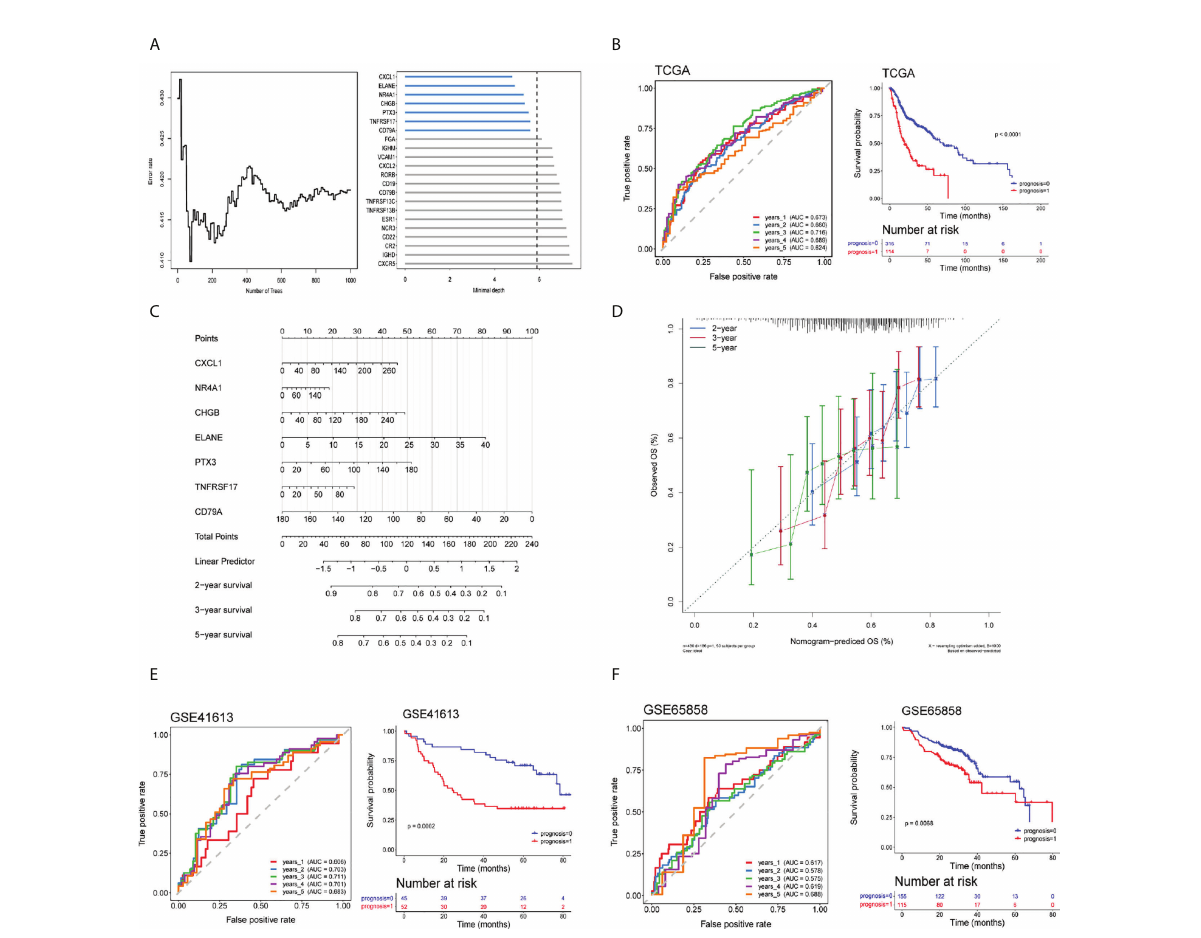
FIGURE 5 Establishment of a risk assessment model using differentially expressed immune-related genes (DEIRGs). (A) Random forest algorithm of DEIRGs for further model gene selection. (B) ROC and Kaplan – Meier curves of seven DEIRGs-based model on OS at 1 – 5-year follow-up in the TCGA training cohort. (C, D) Nomogram based on the seven DEIRGs-based model (C) and calibration curve for the prediction 2-, 3-, and 5-year OS (D) . (E, F) ROC and Kaplan – Meier curves of the seven DEIRGs-based model on OS at 1 – 5-year follow-up in the Gene Expression Omnibus (GEO) validation cohort-GSE41613 (E) and GSE65858 (F)